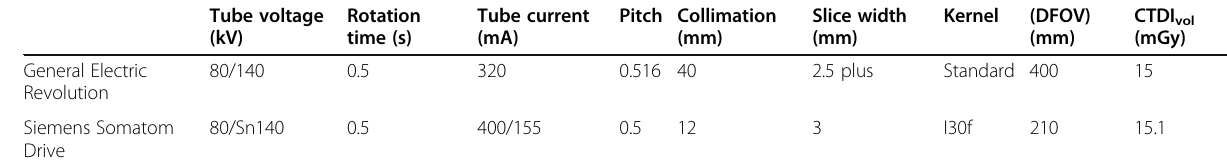
Table 1 Scan parameter settings used for phantom scans for all phantom sizes and iodine concentrations Tube voltage